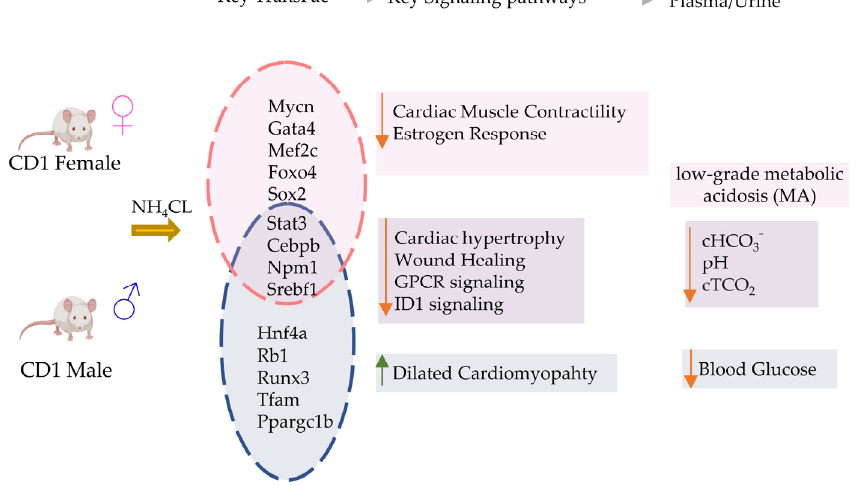
Figure 5. Summary of key transcriptional and electrolyte changes in male vs. female mice with acidosis. Differential regulation of transcriptional factors causes activation (Up arrow) or inhibition (down arrow) of key cardiac specific signaling pathways in male vs female mice. The blood chemistry was similar in both mice groups.